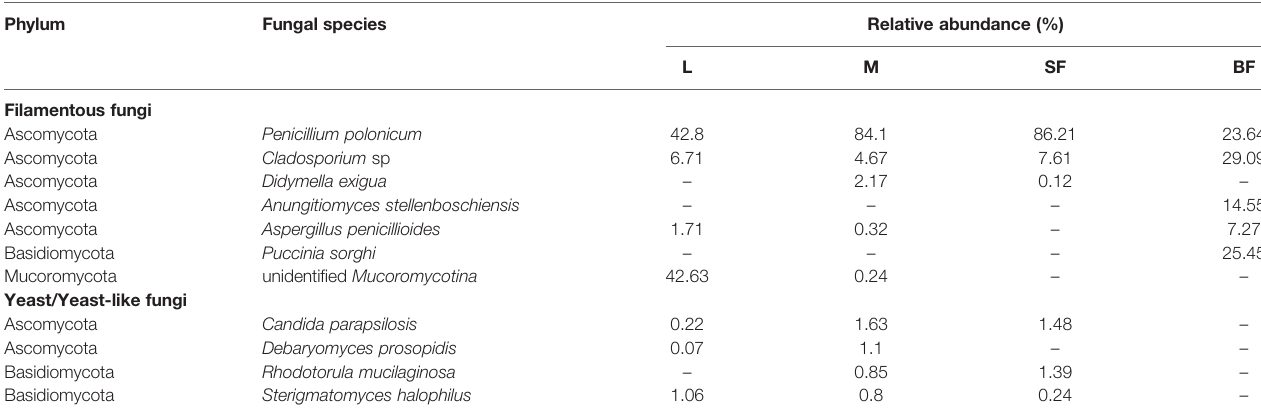
TABLE 2 | Fungal classi fi ed OTUs identi fi ed throughout Cx. quinquefasciatus development. Phylum